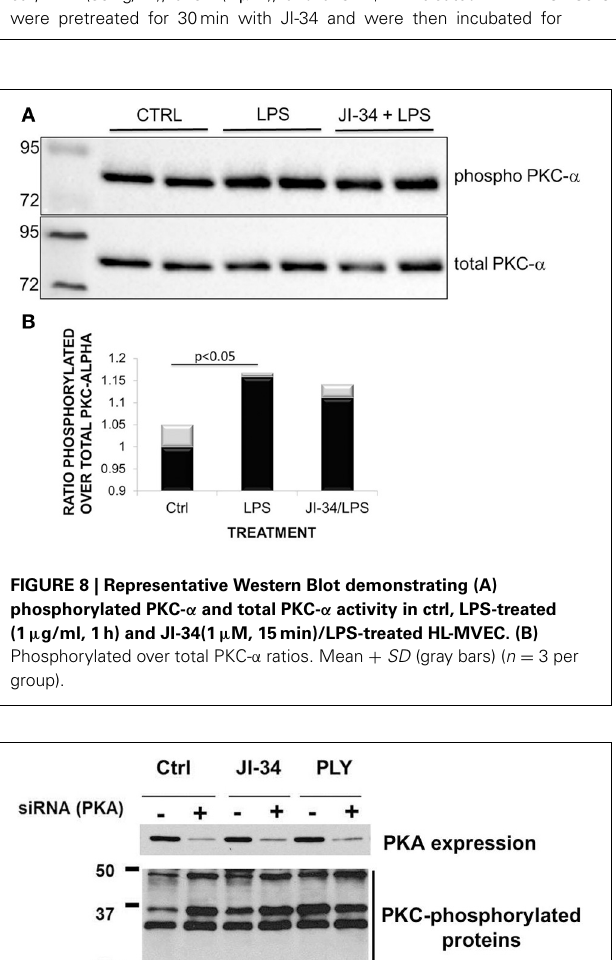
detected in the total PKC activity. As shown in Figure 10B , at a lower PLY concentration (15 ng/ml), the protective effect of JI-34 may shift even to a deleterious one in PKA-gene depleted cells.